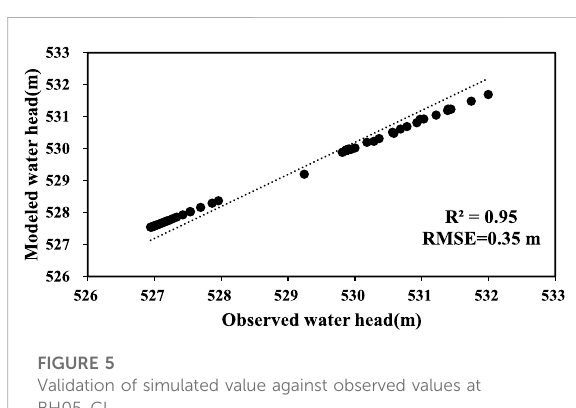
FIGURE 5 Validation of simulated value against observed values at